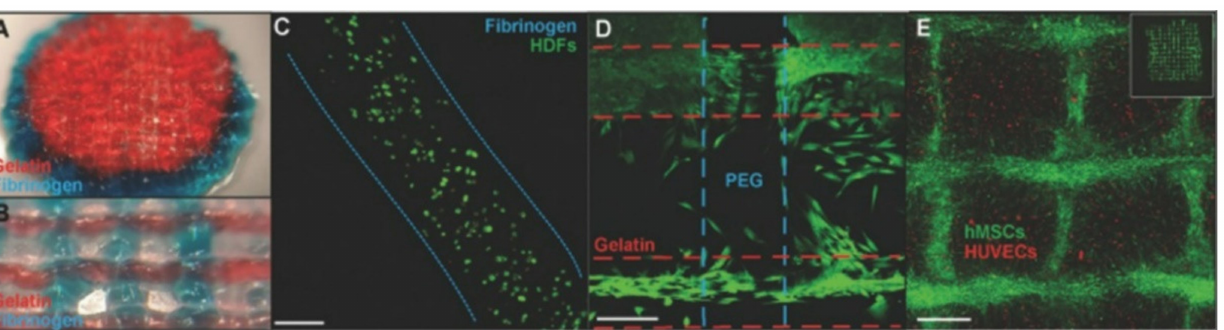
Figure 1. Cell-laden bioprinting. ( A ) Polyethylene glycol ending in two reactive groups (PEGX)- gelatin (red) and PEGX-fibrinogen (blue) coprinted cylinder, 15 mm diameter. ( B ) Coprinting